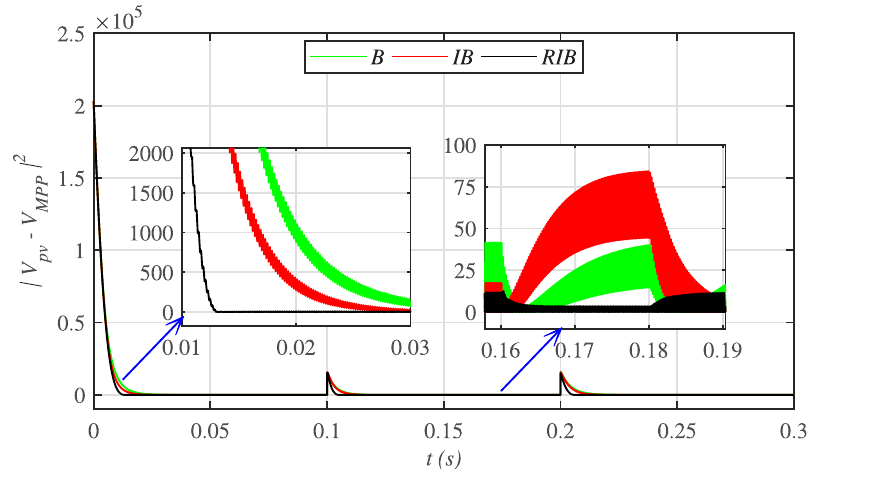
Fig 25. PV array output voltage tracking error under case